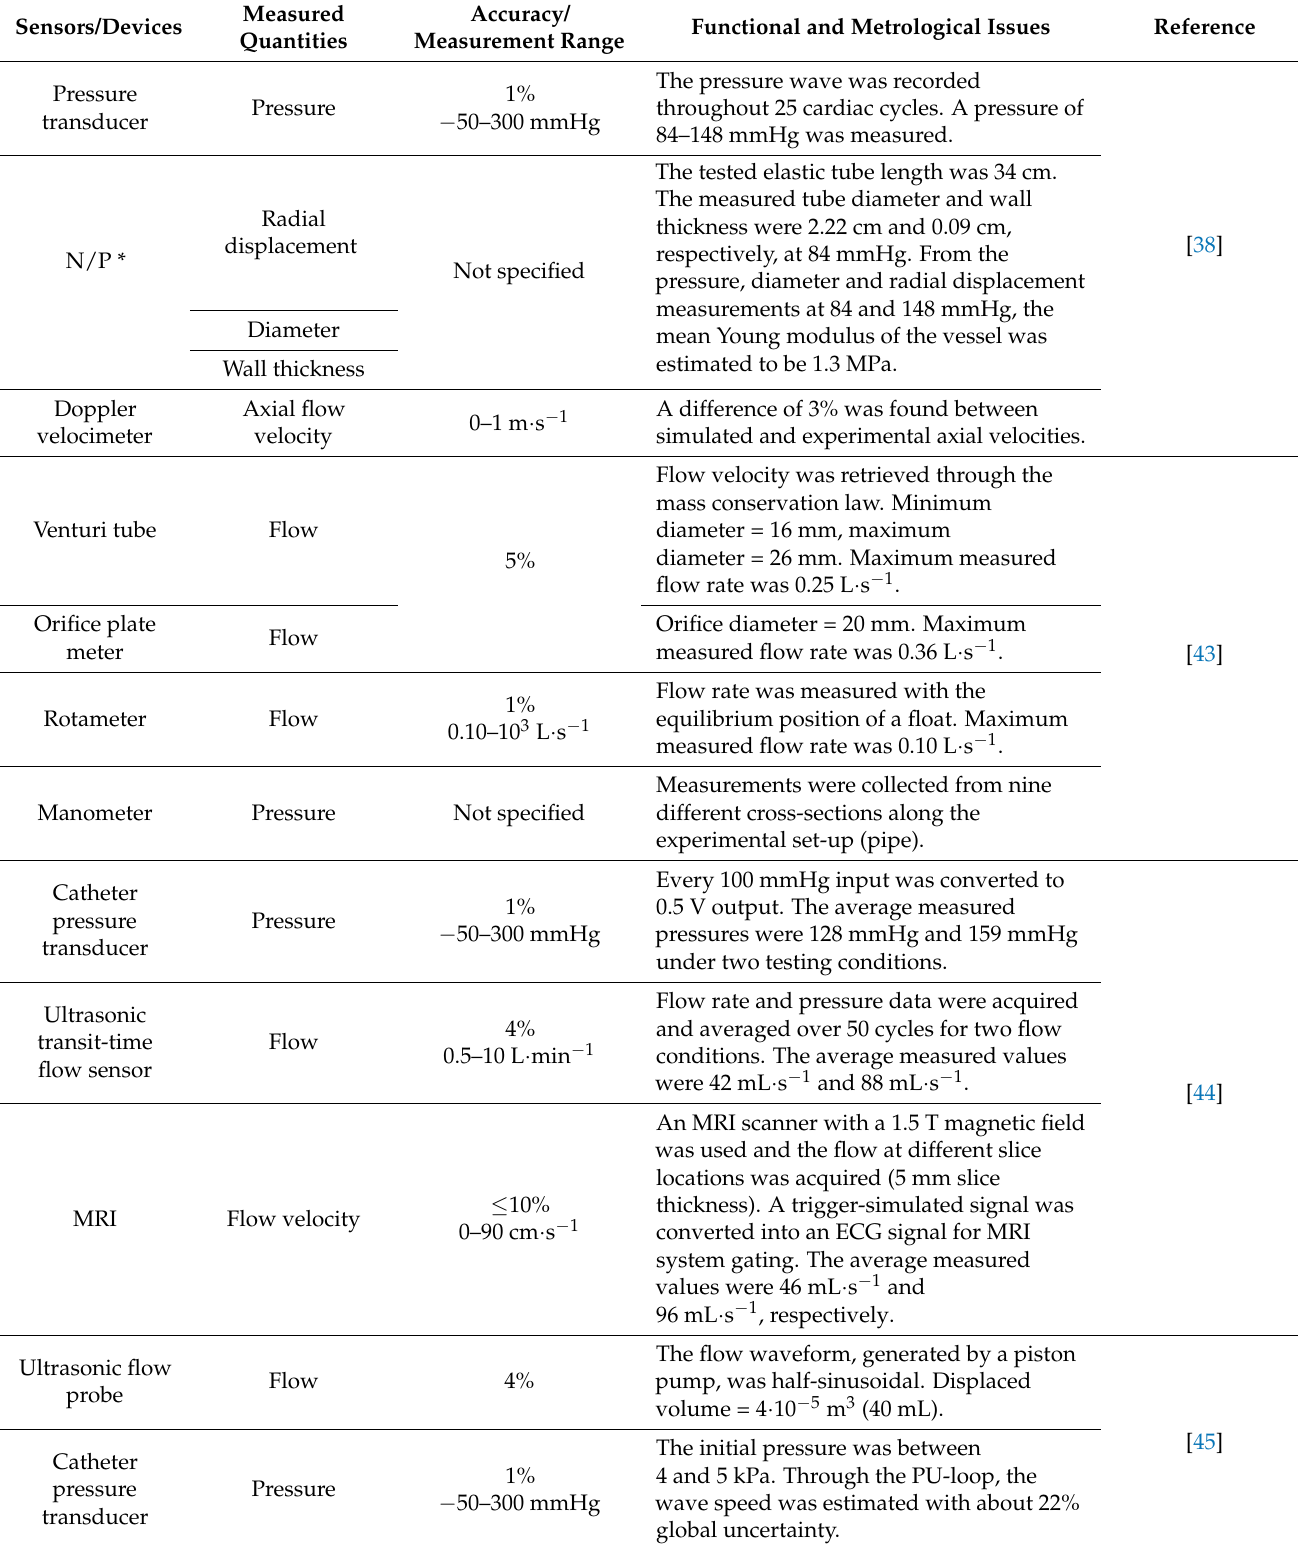
Table 4. Overview of arterial flow